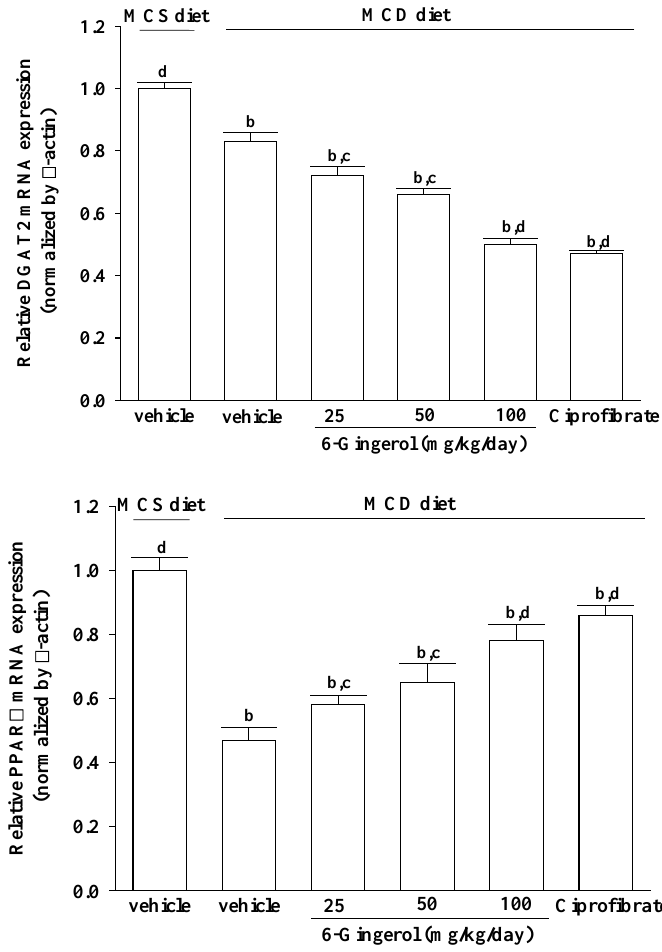
Figure 7. Effects of different treatments on DGAT2 and PPARα mRNA expression in liver tissue. MCD diet-fed mice were administered either 25, 50, or 100 mg/kg/day of 6-gingerol or 10 mg/kg/day of ciprofibrate (ciprofibrate) by oral gavage once daily for four weeks. Another group of mice were administered the same volume of vehicle (distilled water) used to prepare the test medication solutions. The results are means ± SD for eight mice/group after four weeks of treatment. a p < 0.05 and b p < 0.01 compared to the values of vehicle-treated MCS-diet fed mice. c p < 0.05 and d p < 0.01 compared to the values of vehicle-treated MCD-diet fed